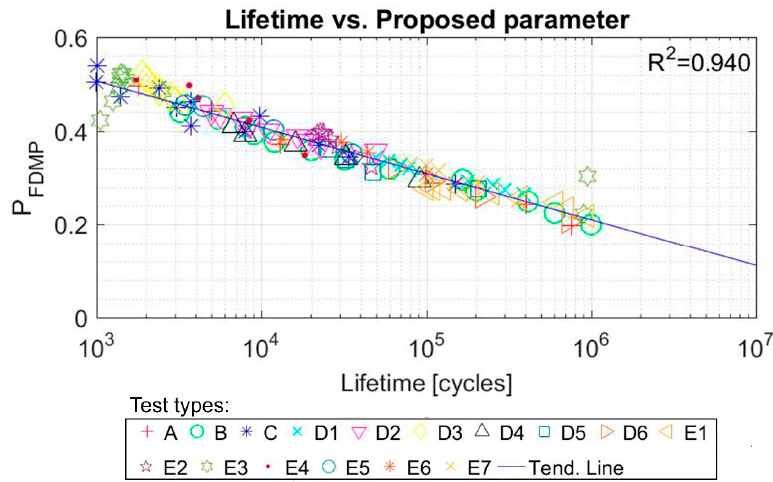
Figure 14. Proposed FDMP and tests lifetime (cycles) correlation for SBR tests. Initial data from [46].